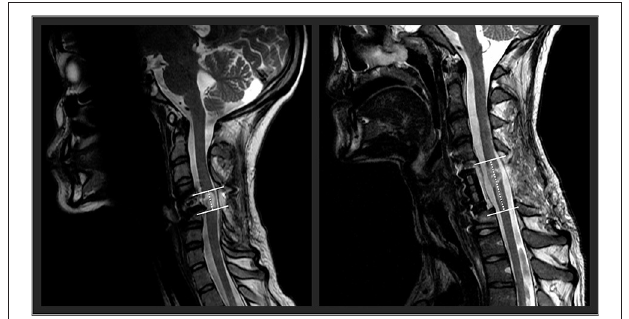
FIGURE 2 | Two representative participants’ midsagittal T2 weighted MRIs are shown. The cranial-caudal lesion boundaries are identified in white lines, while the lesion lengths are depicted in the dotted lines. On the left panel, this participant had a relatively shorter lesion length compared to the participant’s lesion in the right